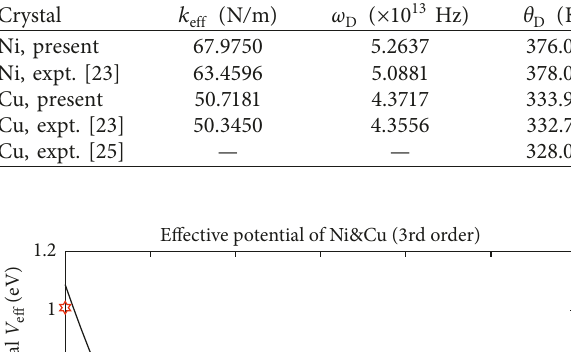
eff , Debye frequency